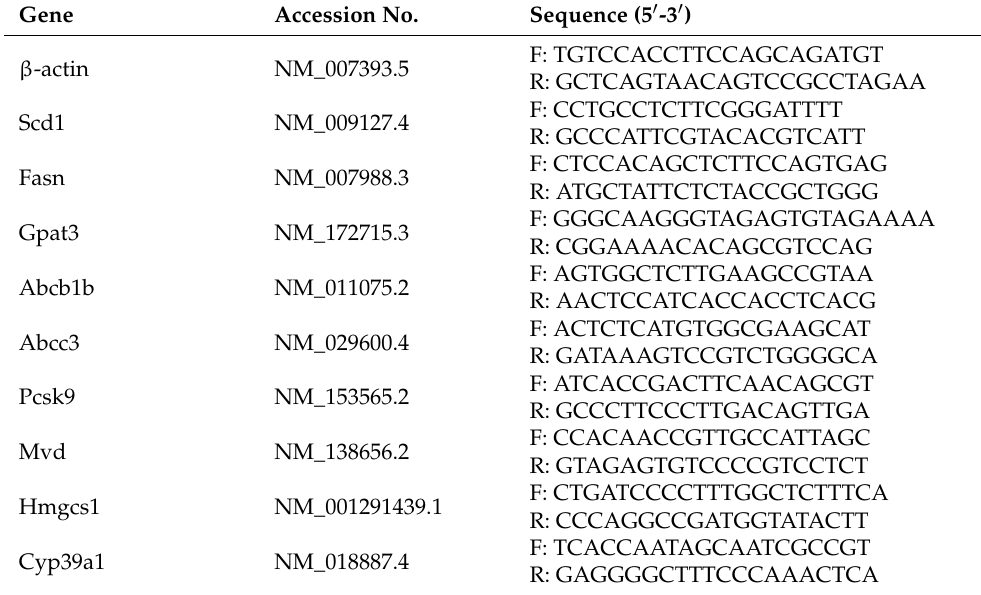
Table 2. Primers used for qPCR